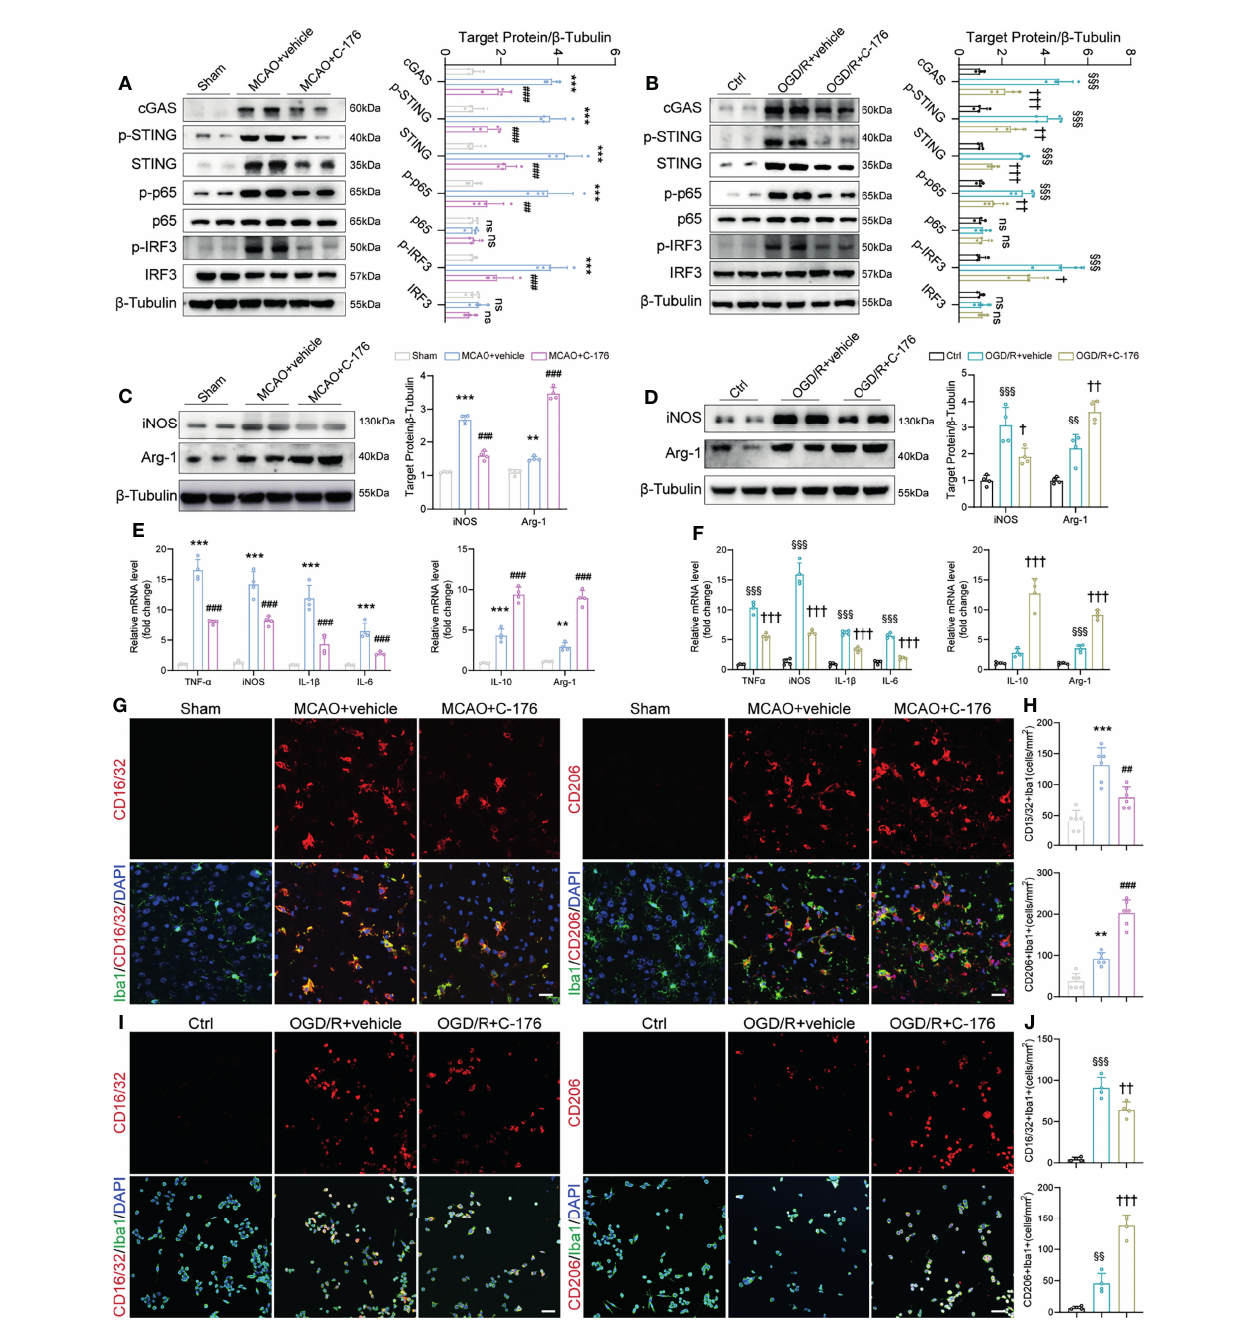
FIGURE 4 | The STING inhibitor C-176 promoted M2 polarization after MCAO. (A) Immunoblotting analysis of cGAS, p-STING, STING, p-p65, p65, p-IRF3 and IRF3 in the peri-infract tissue of Sham, MCAO+vehicle and MCAO+C-176 mice 1d post-MCAO. n = 4. (B) Immunoblotting images and quantitative analysis of cGAS, p-STING, STING, p-p65, p65, p-IRF3 and IRF3 in BV2 microglia of Ctrl, OGD/R+vehicle and OGD/R+C-176 group 24h after reoxygenation. n = 4. (C, D) Western blot and quanti fi cation analysis for iNOS and Arginase-1 in treated mice 3d post-MCAO and BV2 microglia 24h post-reoxygenation. n = 4. (E, F) mRNA expression of pro-in fl ammatory genes (TNF- a , iNOS, IL-1 b and IL-6) and anti-in fl ammatory genes (IL-10 and Arg-1) were measured by real-time PCR 3d after MCAO and 24h after OGD/R. n = 4. (G) Representative confocal images of two microglia phenotypes were obtained from the peri-infarct cortex. (H) Quanti fi cation of CD16/32 positive M1 microglia and CD206 positive M2 microglia in the treated mice. n = 6. (I, J) Representative immunostained images and statistical analysis of M1 state (CD16/32 + /Iba1 + ) and M2 state (CD206 + /Iba1 + ) BV2 microglia. n = 4. Data are expressed as mean ± SD. ** P < 0.01, *** P < 0.001 vs Sham group; ## P < 0.01, ### P < 0.001 vs MCAO+vehicle group. §§ P < 0.01, §§§ P < 0.001 vs Ctrl group; † P < 0.05, †† P < 0.01, ††† P < 0.001 vs OGD/R+vehicle group. n. s., no signi fi cant difference. Scale bar = 20 m